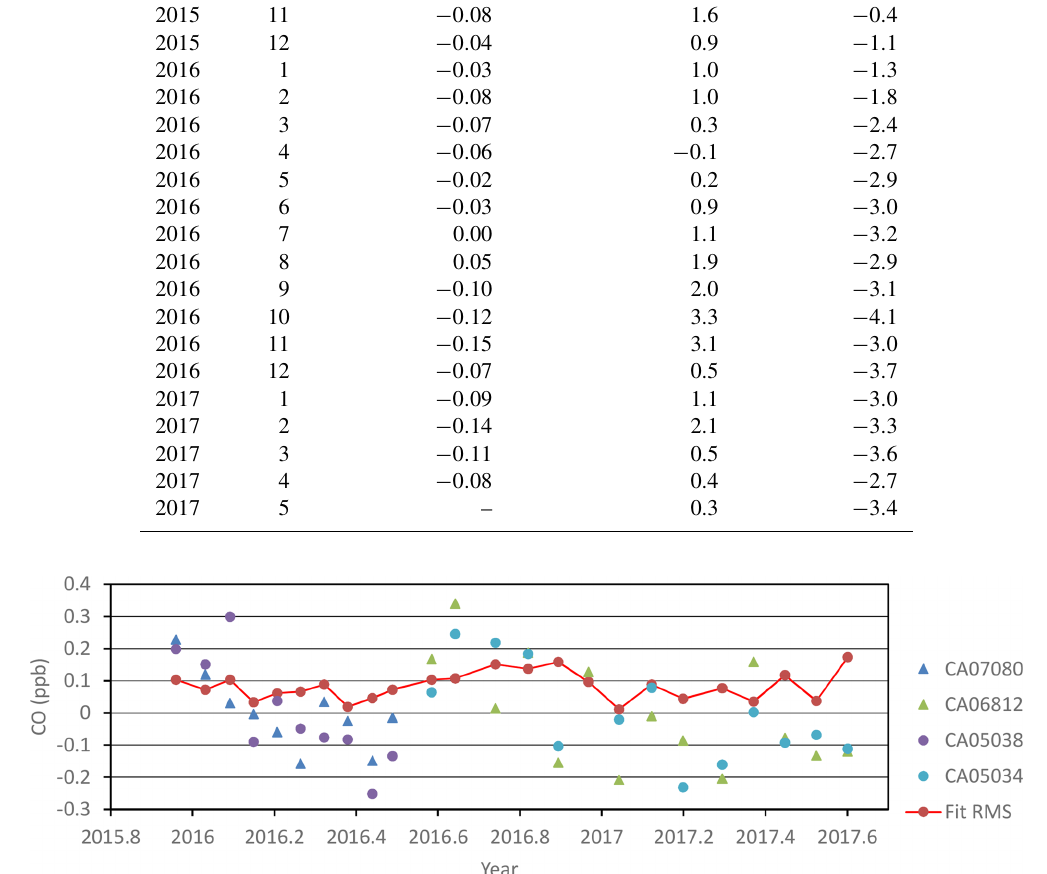
Figure 16. The rms residual of the fit (red dots/line), and difference between the assigned mole fraction to a target gas and the mean mole fraction of such a target gas (a different color is used for each target gas), for each species and mole-fraction calibration performed using four WMO laboratory standards (every 3 or 4 weeks), after taking into account the drift rates of the CRDS